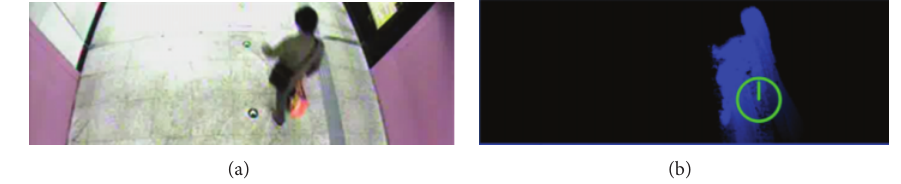
Figure 7: (a) Original ROI-image. (b) MHI ROI-image.